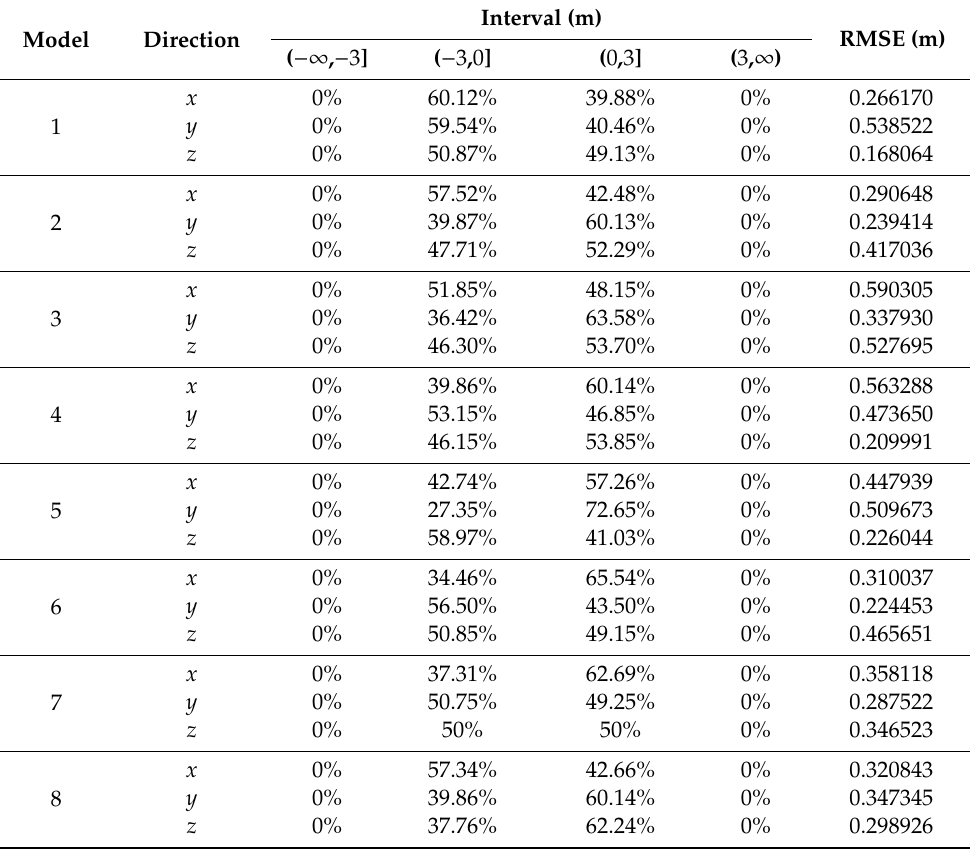
Table 7. Absolute geolocation error and its distribution. RMSE—root-mean-square